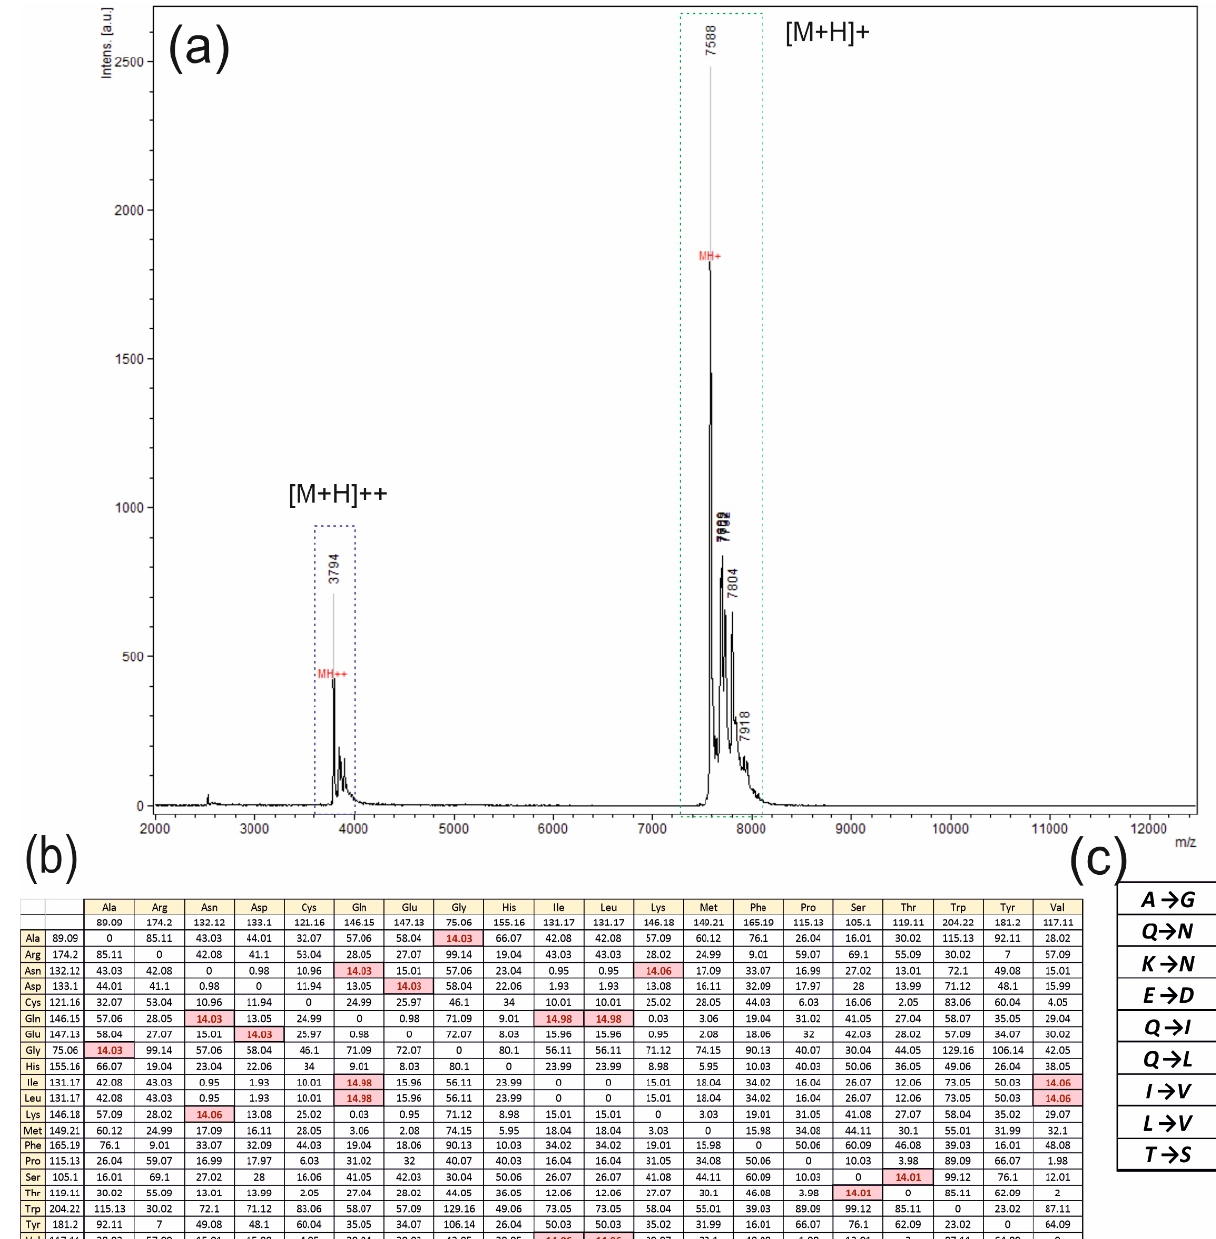
Figure 3. Analysis of peaks with the MALDI-TOF MS method. ( a ) The spectrum with two fields of peaks is presented. The main peak, with a mass of 7588 Da, is highlighted with others in one set in the dotted rectangle colored in green, and another set of peaks with the main peak mass of 3794 Da is highlighted with the blue dotted rectangle. Symbols [M+H] + and [M+H] ++ mean the masses of the molecular ions plus proton, the single-charged and double-charged ions, respectively. ( b ) The table, including information about the molecular mass differences between each of the natural amino acids; results are presented in Da units, and the goal of 14 Da, meaning between corresponding amino acids, is colored in red. ( c ) The set of possible amino acid single changes in the hydrophobin, calculated over the molecular masses, is presented.